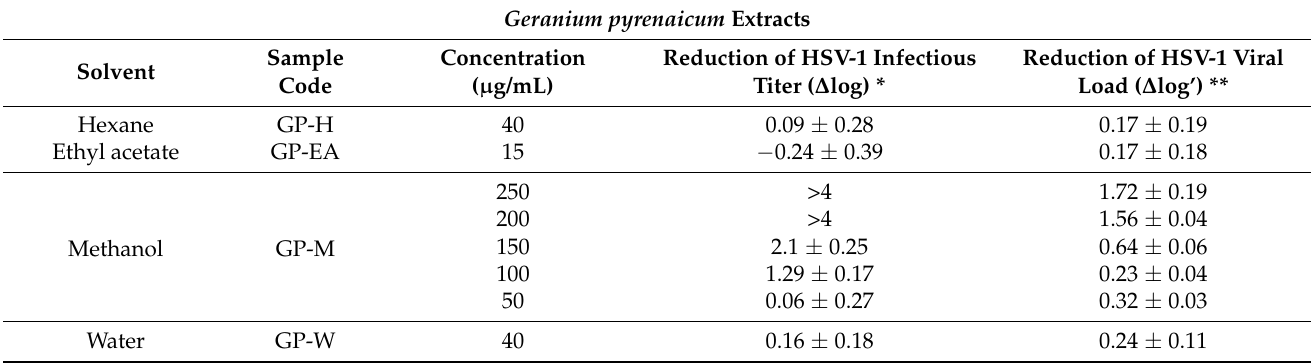
Figure 2. Influence of Geranium pyrenaicum extracts on HSV-1 induced CPE formation in VERO cells. Table 6. Reduction of HSV-1 infectious titer and viral load by the Geranium pyrenaicum extracts. Geranium pyrenaicum